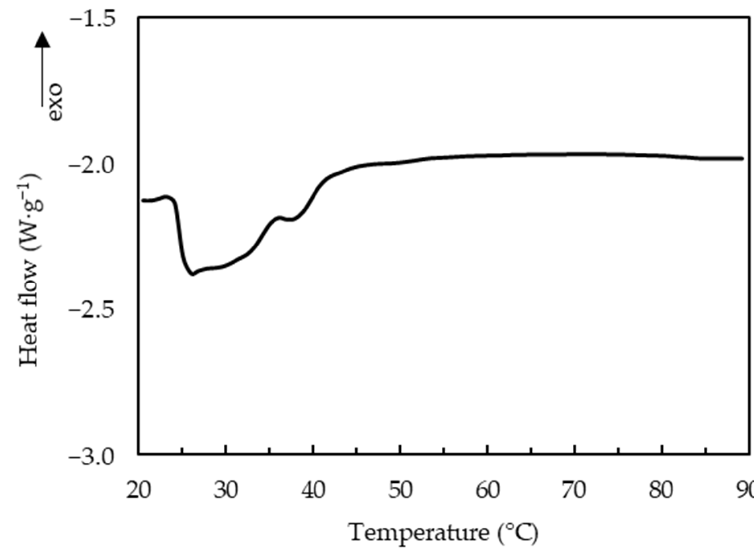
Figure 6. Differential scanning calorimetry curve of uncooked curd.